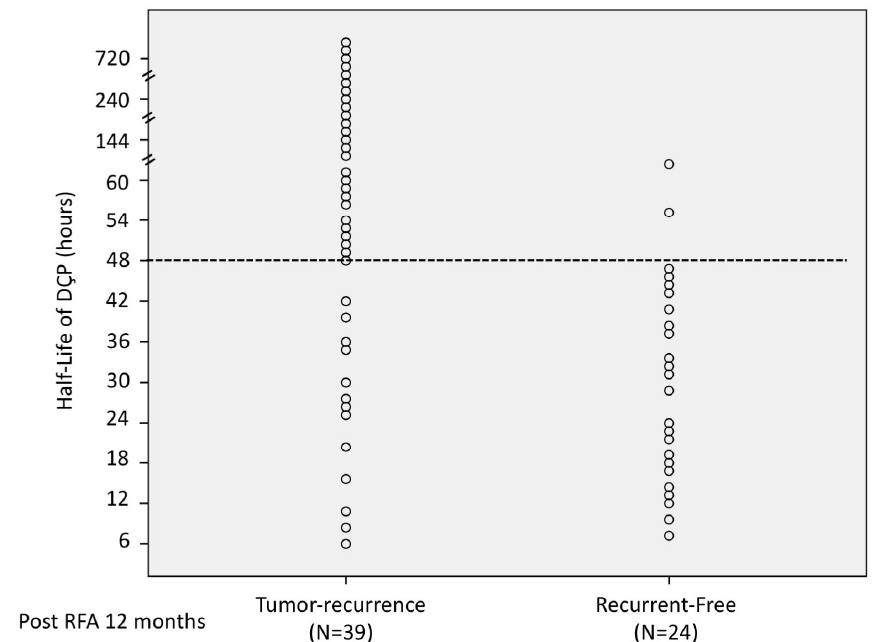
Diagnostics 2023 , 13 , 696 Figure 3. The distribution of 63 patient’s HLs of Des-gamma-carboxy prothrombin (DCP) stratified according to the tumor recurrence at 12 months post radiofrequency ablation therapy (RFA) ablation.